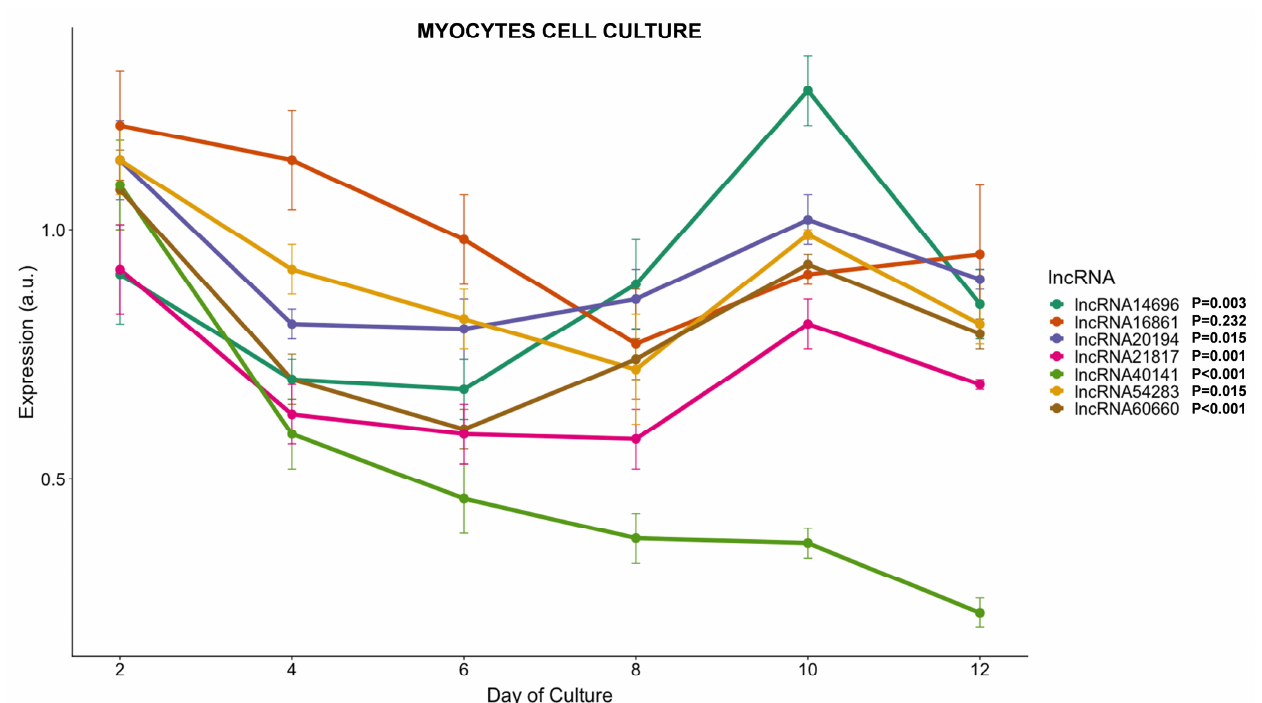
Figure 6. LncRNAs transcription during myocytes cell culture development. Plot showing gene expression of 7 lncRNAs during gilthead sea bream fast skeletal muscle myocytes cell culture. Gene expression is expressed as average ± SD ( n = 6) of arbitrary units (a.u). The statistical effect of fasting and refeeding is indicated for each lncRNA